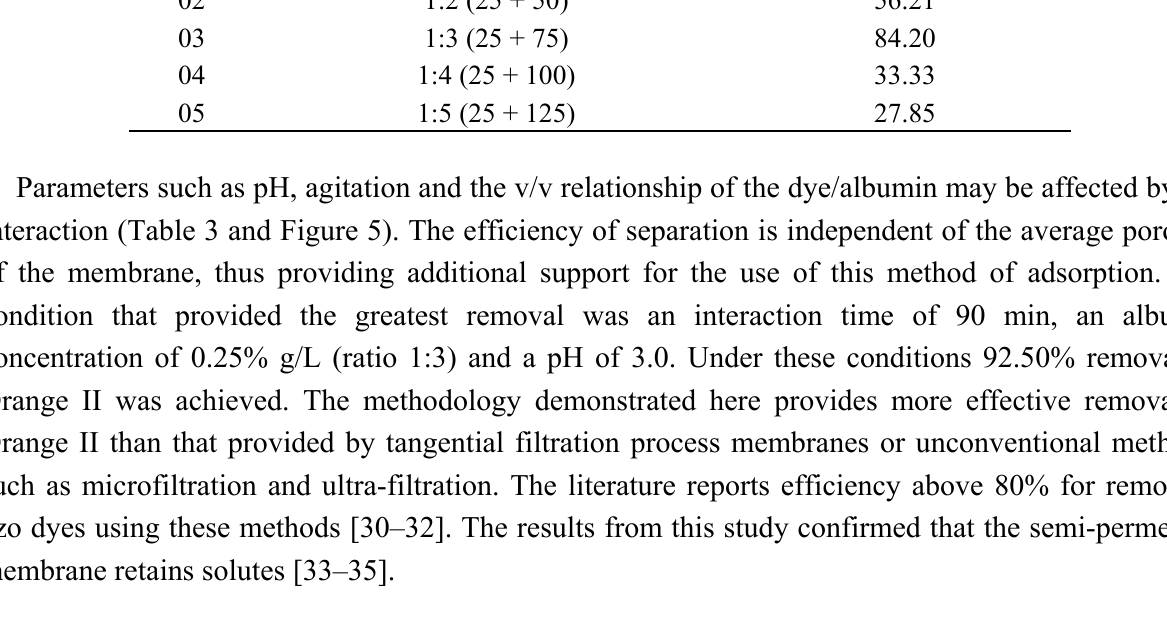
C = concentration of adsorvate. Co = concentration of initial adsorvate.